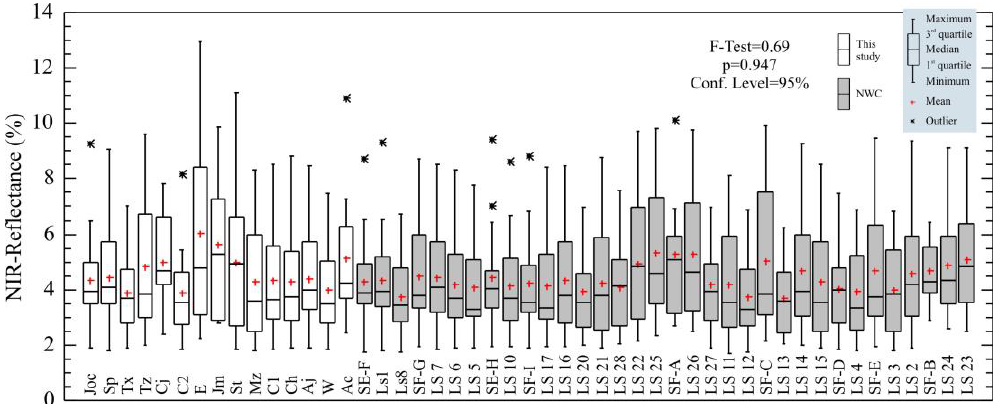
Figure 7. Analysis of variance of 49 the sampling sites into Lake Chapala. Tag-descriptions are listed in Table 1, and locations in Figures 1 and 2.